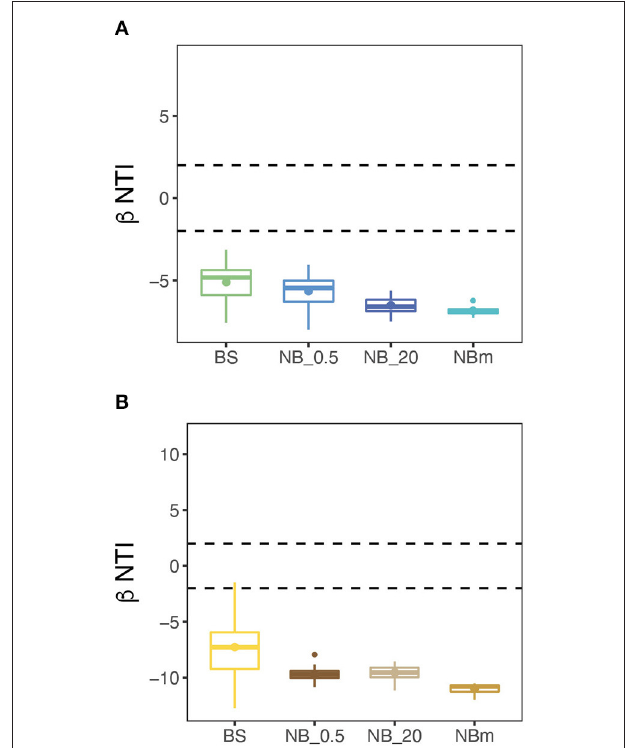
FIGURE 6 | Null model analysis suggests that a strong deterministic selection process with homogeneous selection is prevalent across the study transect. This was supported by the Beta Nearest Taxon Index ( β NTI) for unweighted abundances between grouped prokaryote (A) and microeukaryote (B) communities indicating strong consistent (homogeneous) community selection. Dashed lines mark the significance thresholds ( β NTI > 2 and β NTI < − 2) for deterministic selection processes: β NTI > 2 is an indication for variable deterministic selection and β NTI < − 2 indicates homogeneous deterministic selection. The stochastic selection process occurs when β NTI-values are between the dashed lines ( − 2 < β NTI <